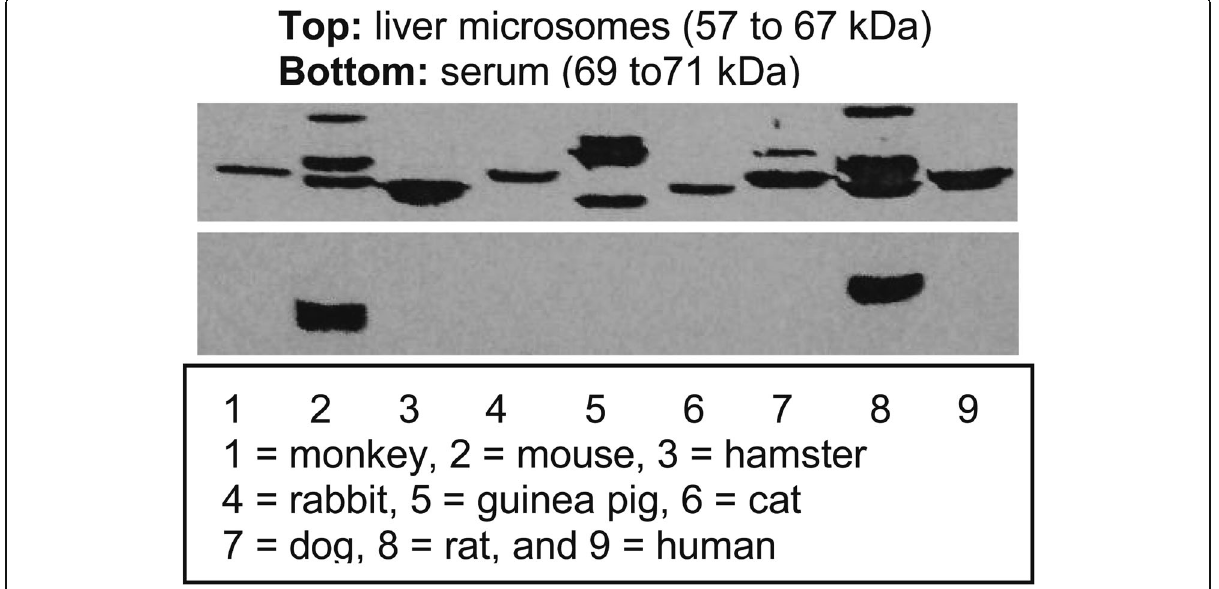
Fig. 4 Immunoblots of liver microsomes and serum from various species with anti-rat Ces1d. Microsomes (10 μ g) or serum (0.5 μ L) from mature males were resolved by 7.5% SDS-PAGE and transferred electrophoretically to nitrocellulose membranes. The blots were blocked by milk and detected by the antibody against recombinant rat Ces1d through E. coli expression system. This antibody has been shown to have a